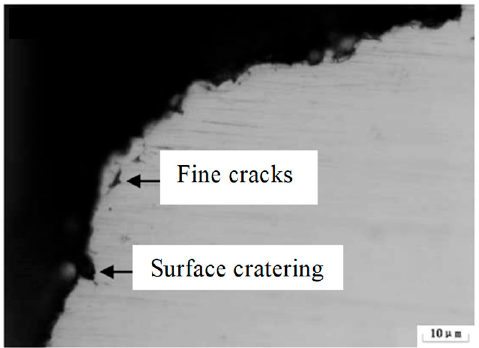
Figure 6. Unetched high magnification morphology of the origin of the boom fracture sent for inspection.